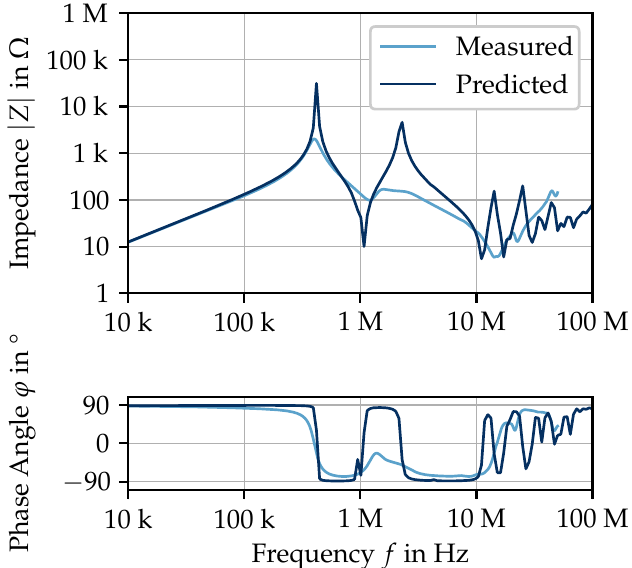
Figure 11. Measured and model impedance magnitude and phase angle of both stator specimen S3 and S5; f1 and f2 indicate the inter-winding resonances